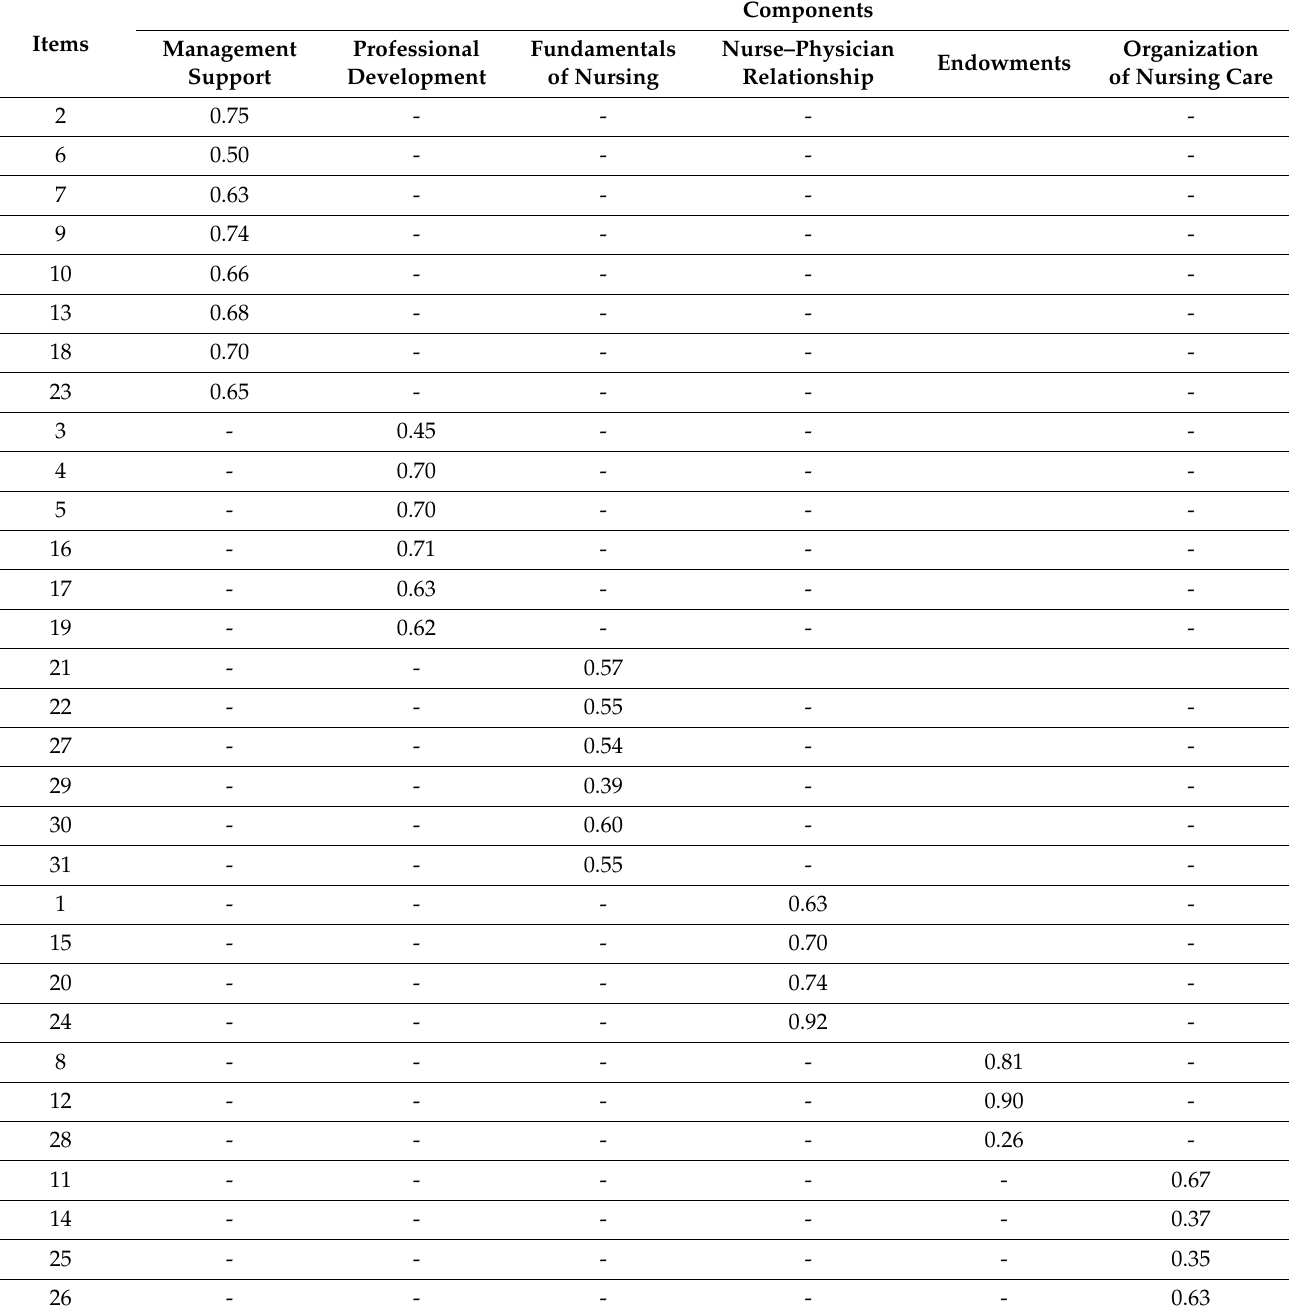
Table 1. Nursing Work Index-R-PT components.